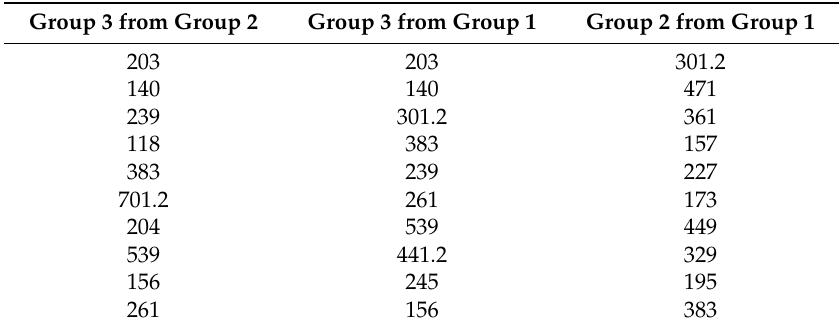
Table 1. m / z bins that separate groups. The top 10 bins showing the strongest contribution in order of their p and q values.